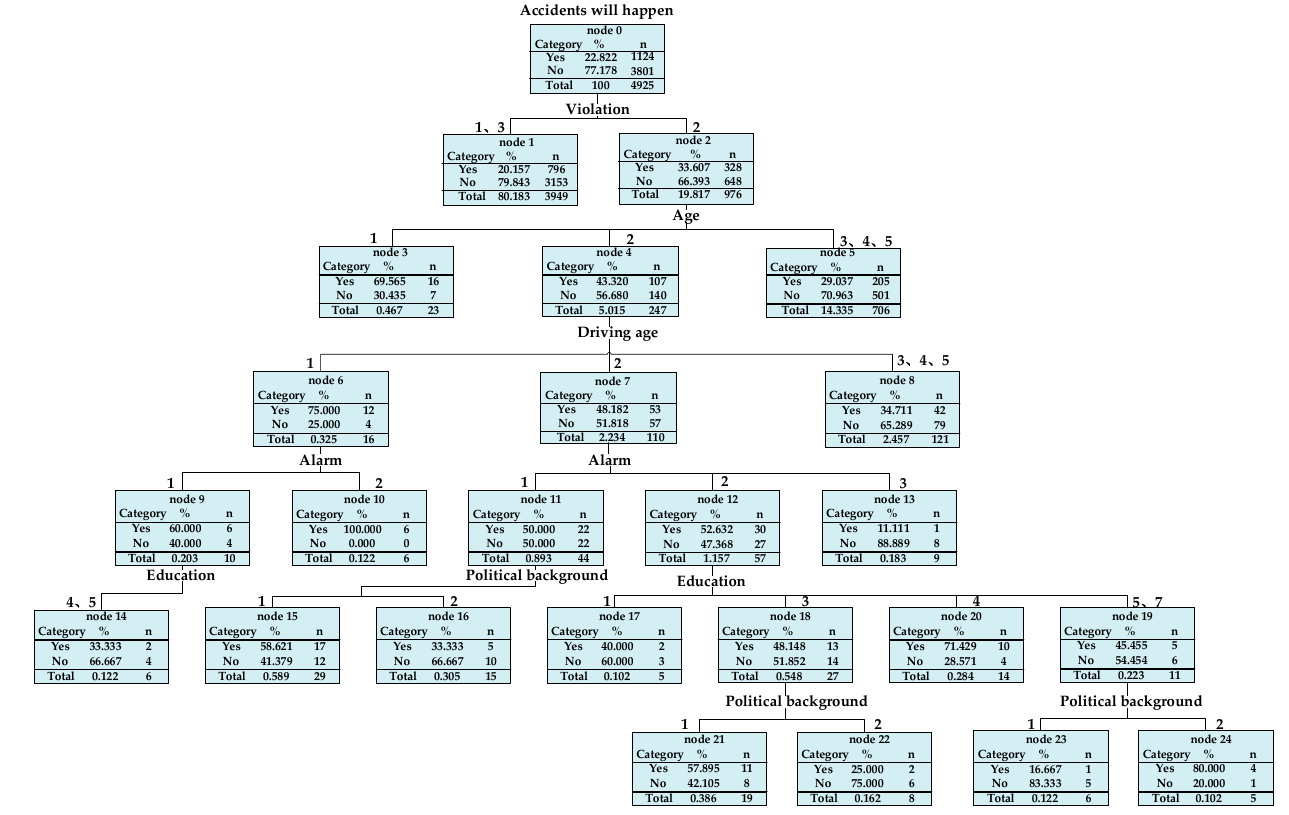
Figure 1. Schematic diagram of the C5.0 decision tree. Each rule set of bus driver accident propensity represents each non-closed directed path in the decision tree split from the top-down nodes. For each rule, each independent variable that can be seen to affect the outcome was selected with an observed sample size of at least 5, a proportion ( S ) of at least 0.1%, and a probability ( Pr ) of at least 10% for the occurrence of the accident dependent variable. The final two columns of the table display the proportion of the rule sample ( V ) and the accident incidence probability ( P ) under the rule. As stated in Table 12, the rules are ordered according to their proportion size. Table 12. Accident occurrence rule set.